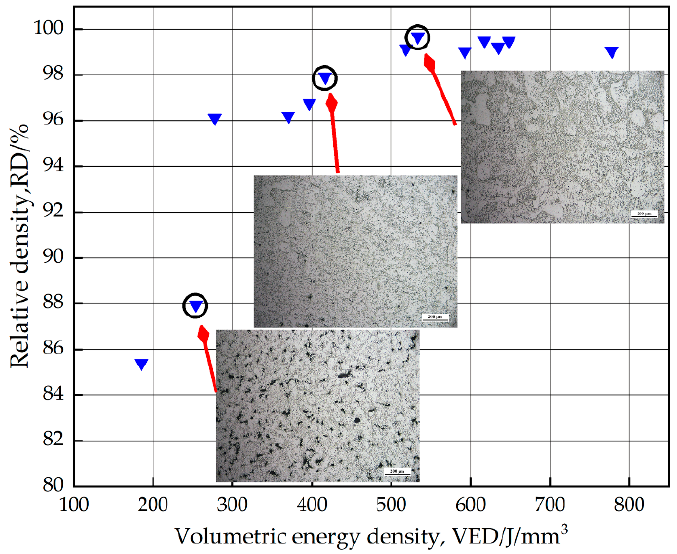
Figure 6. Variation of the relative density with the volumetric energy density. The inserted figure shows the different transverse morphologies corresponding to the VEDs.